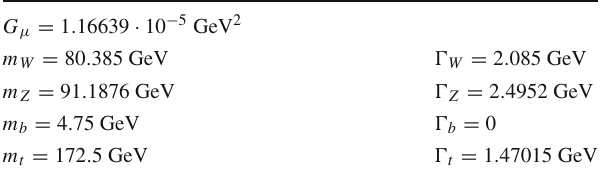
Table 3 Numerical values of all input